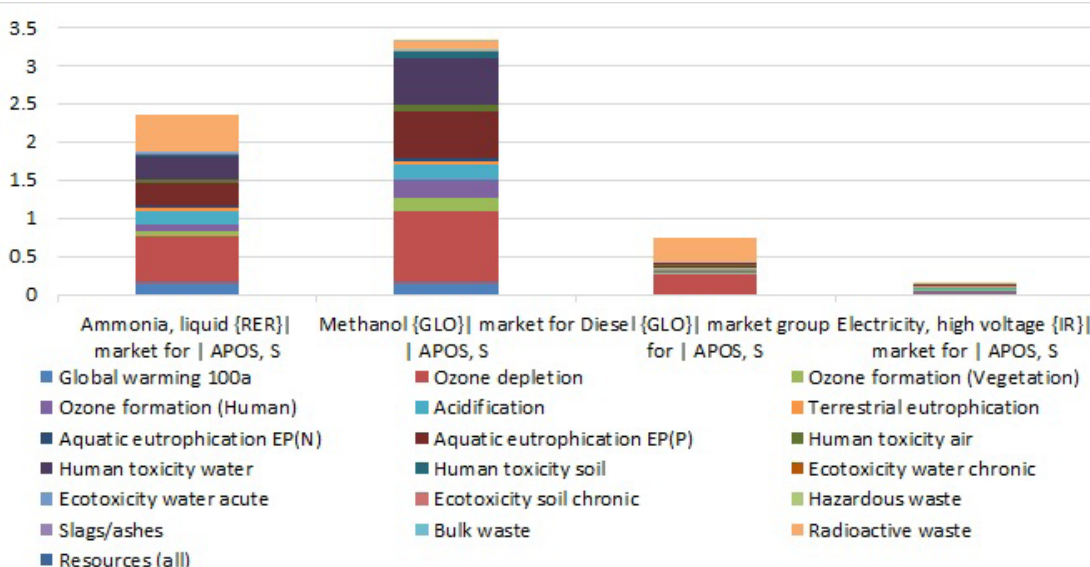
Taghizadeh Isini L, et al. Life Cycle Assessment of Formalin and Hexamine Production Units. J Adv Environ Health Res. 2022;